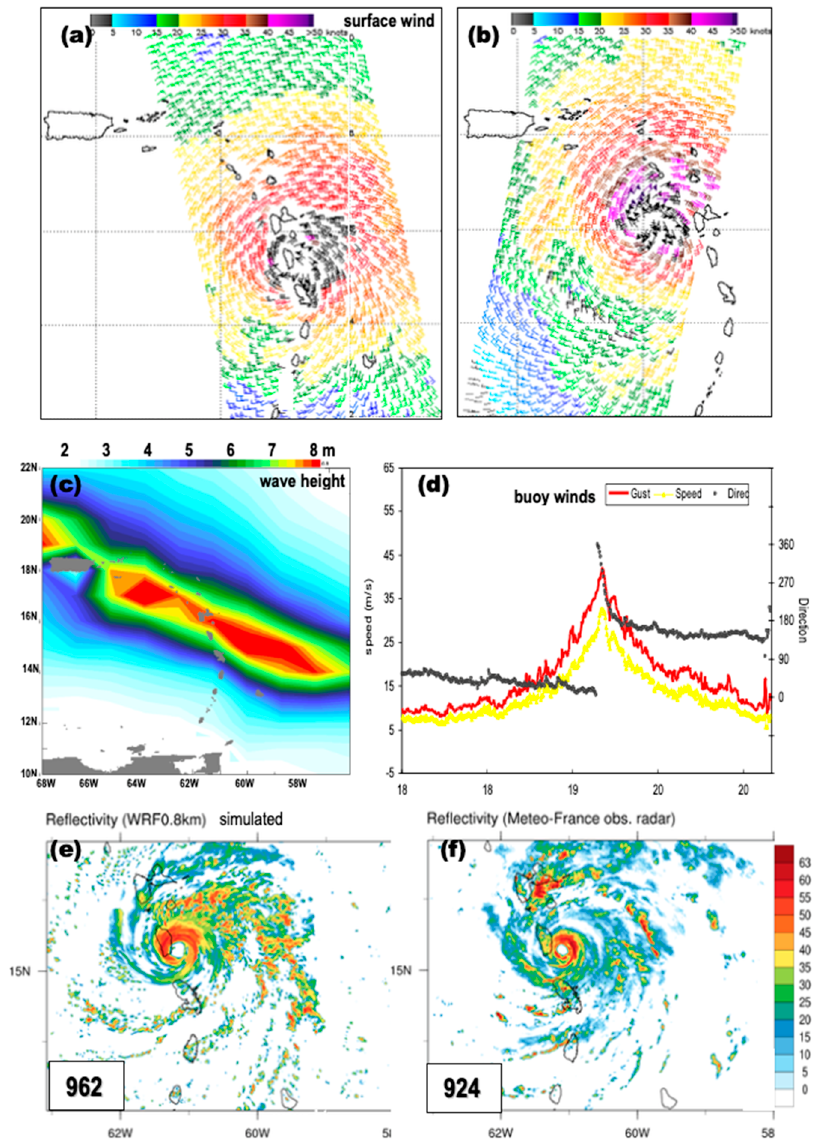
Figure 7. Scatterometer winds on ( a ) 0Z and ( b ) 12Z 19 September 17 of Maria passing the Antilles. ( c ) 17–20 September 2017 averaged maximum Wavewatch3 reanalysis wave height. ( d ) Temporal record of winds at W. Guadeloupe NDBC buoy. ( e ) WRF simulated and ( f ) MeteoFrance observed radar reflectivity at 00Z 19 September 2017, with central pressure values inset.